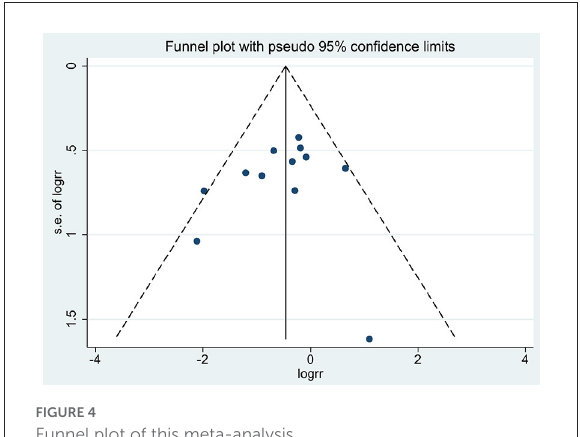
FIGURE4 Funnel plot of this